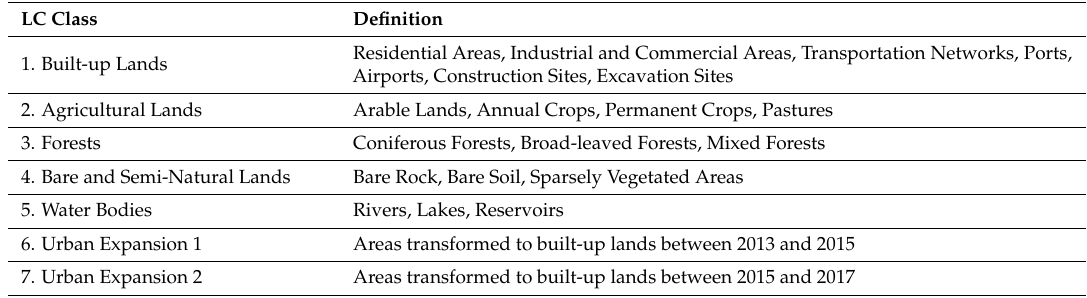
Table 2. Definitions of the land cover classes mapped in this